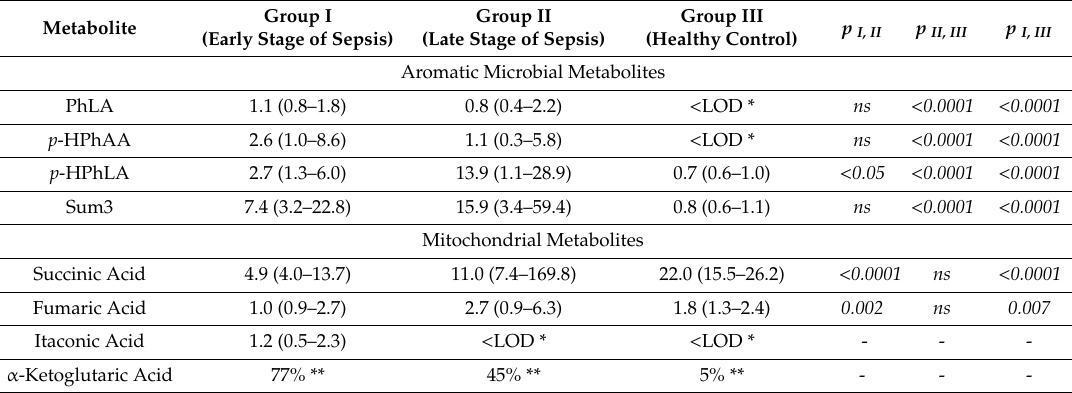
of three groups of samples, Me (IQR 25–75%), µ M.